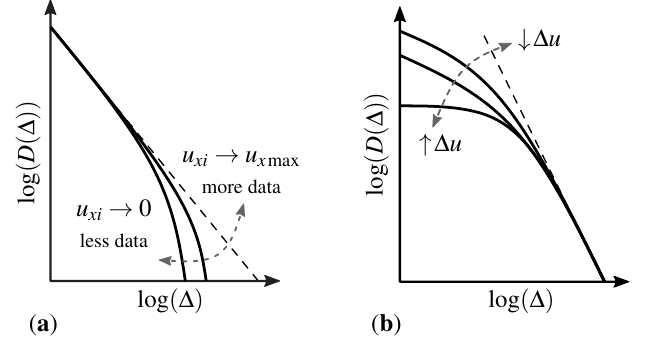
Figure 6. The avalanches distribution in the Bundle Model, defining avalanche as the number of bars that break simultaneously. ( a ) When the prescribed displacement is continuously increased, but the test is stopped before complete failure (i.e., u xi < u x max ). ( b ) When u x is applied in discrete steps with amplitude δ u